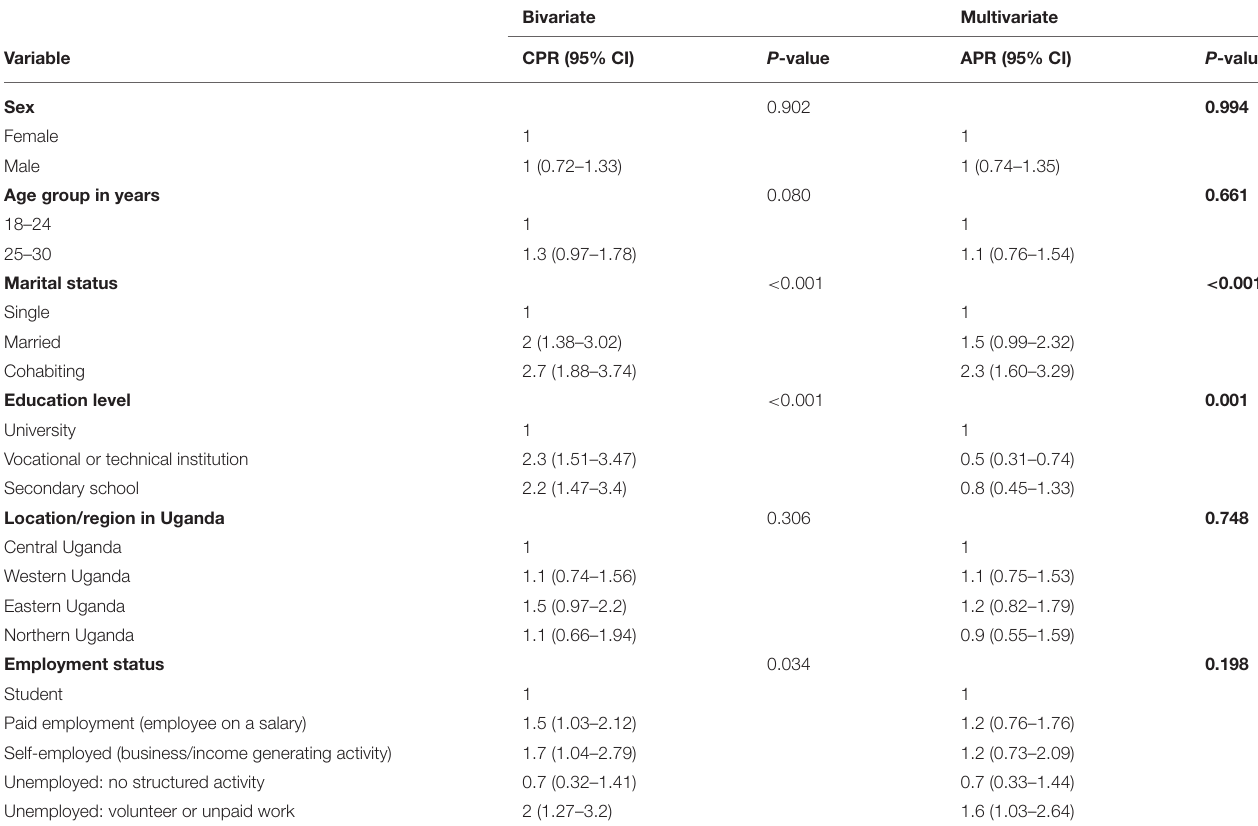
TABLE 4 | Poisson regression of reported SRH problems on socio-demographic and economic factors with reported SRH problems among Ugandan youth during the COVID-19 lockdown.